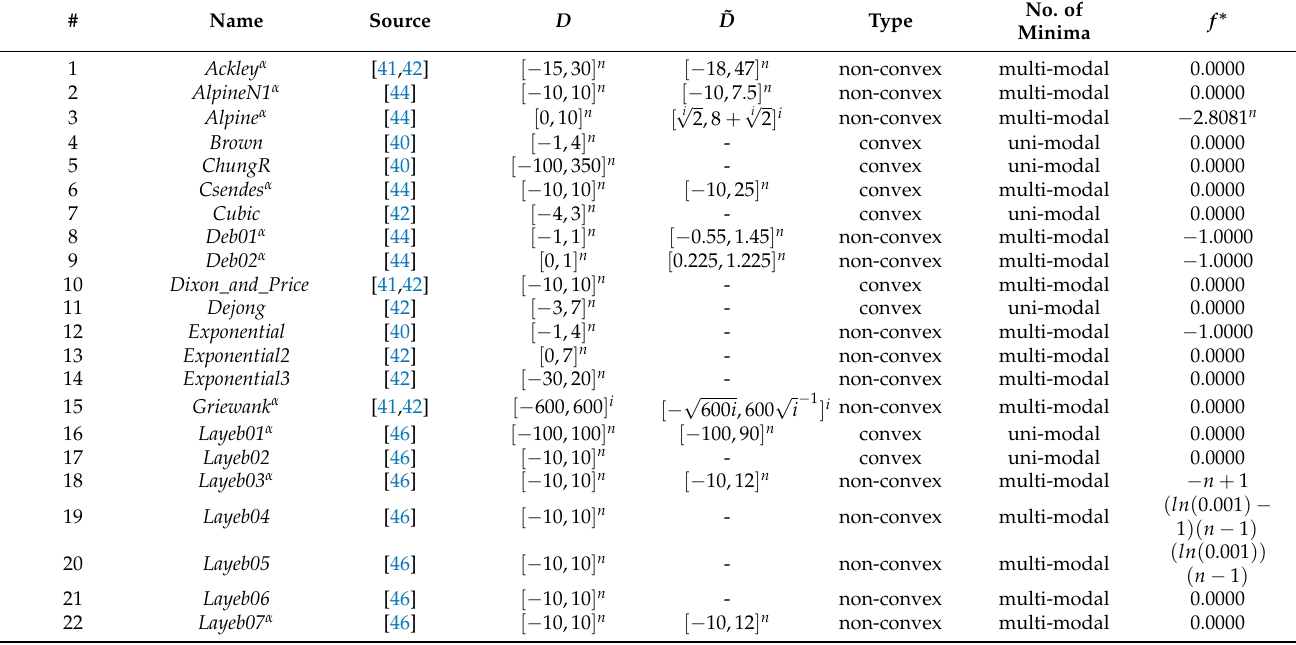
Table A2. Key characteristics of box-constrained global optimization problems with varying n from DIRECTGOLib v1.2 [35]. Data adapted from